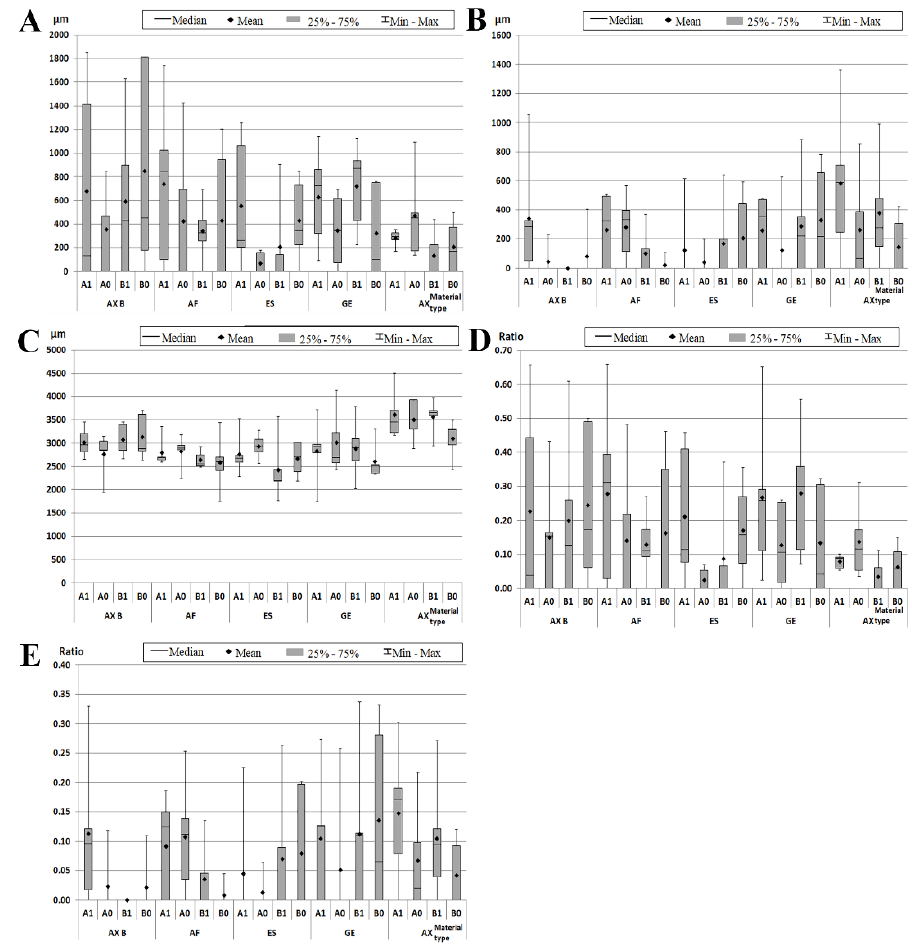
Figure 3. The median and range values of the evaluated parameters in the five groups of restorations, for both types of cavities. Microleakage in cervical area (MLKd) ( A ); microleakage in occlusal area (MLKe) ( B ); total adhesion interface (AIL) ( C ); ratio of cervical microleakage ( D ); and ratio of occlusal microleakage ( E ). Groups I-V restored with AX B = Admira Fusion X-tra applied by bulk fill technique, AF = Admira Fusion, ES= Essentia, GE = G-aenial, AX = Admira Fusion X-tra; A1, B1 = part of the sections containing enamel-located restorations; A0, BO = part of the sections containing cementum-located restorations.